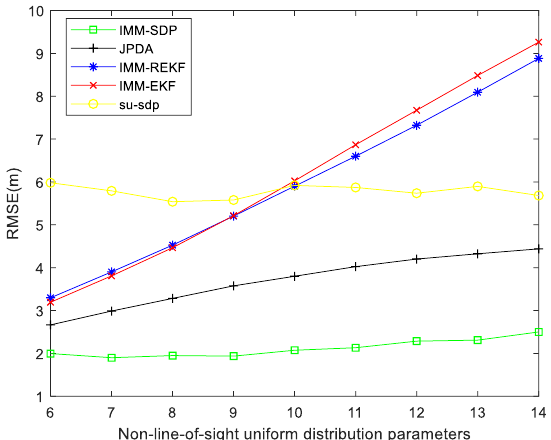
Figure 9. NLOS uniform distribution parameters .